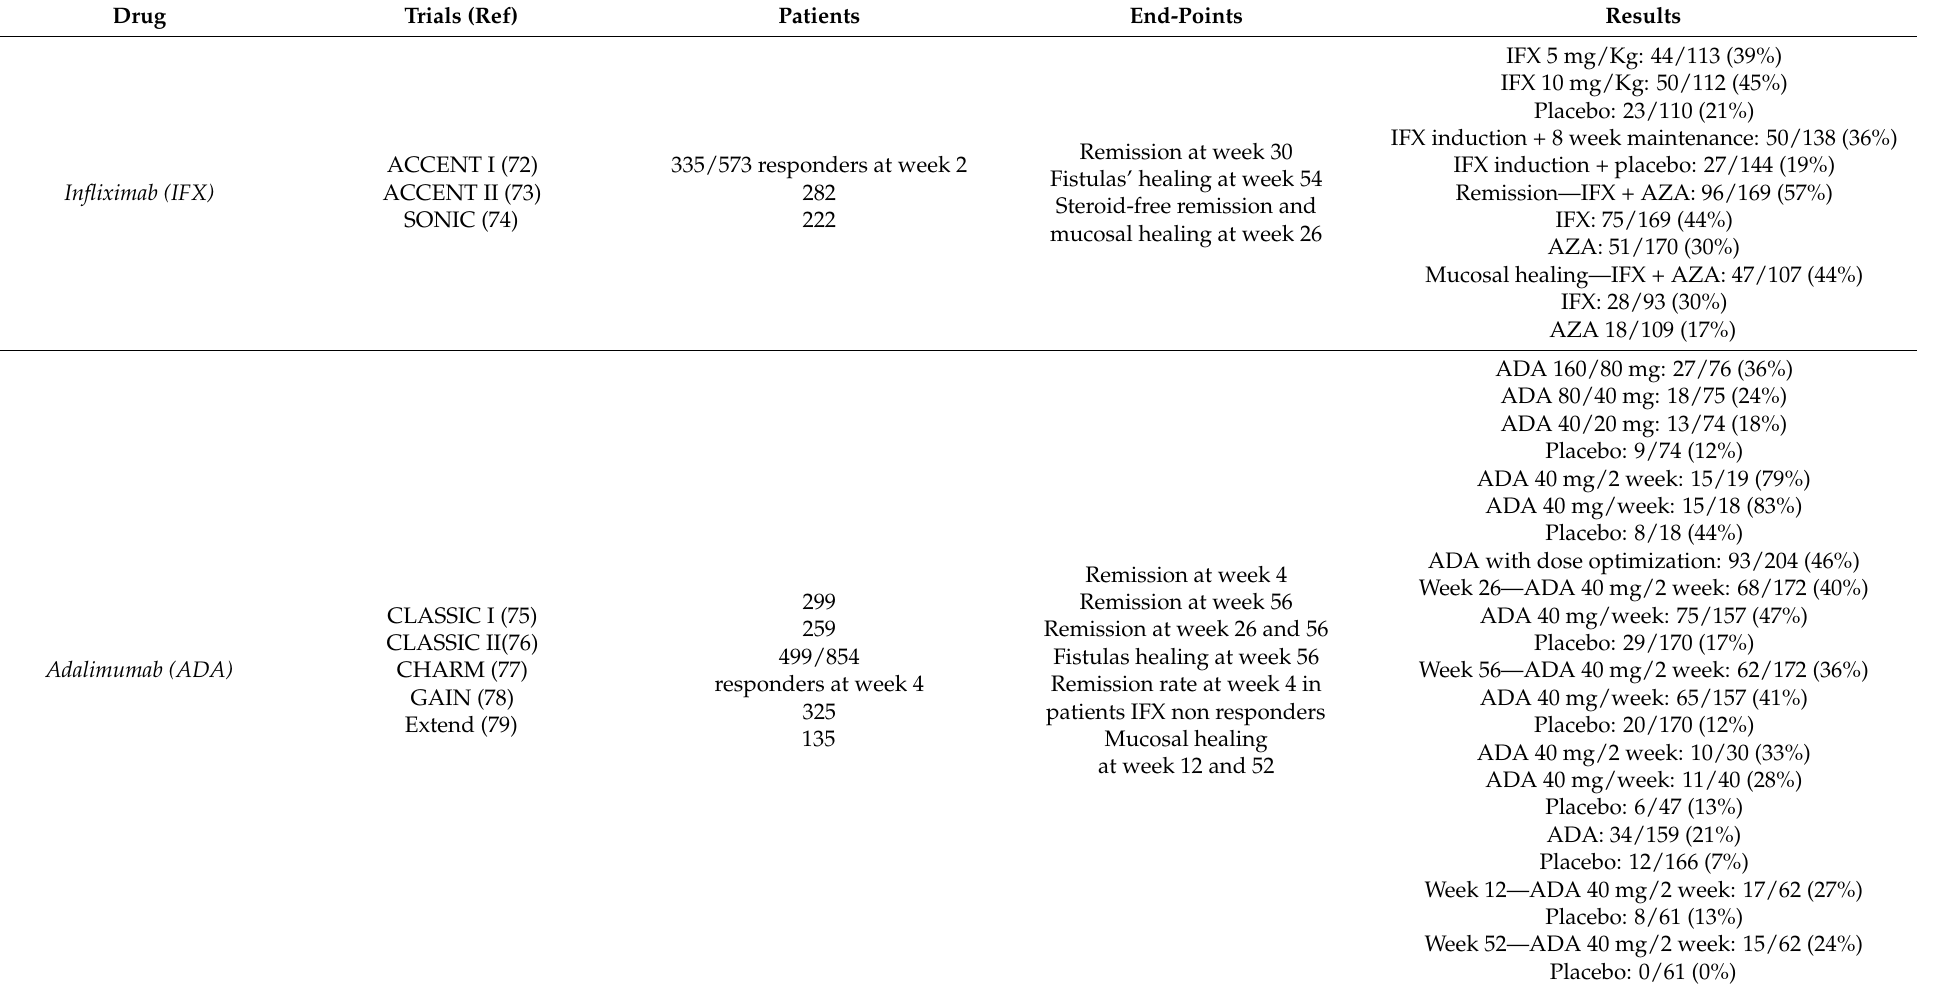
Table 1. Pivotal clinical trials of the three anti-TNF drugs approved for CD